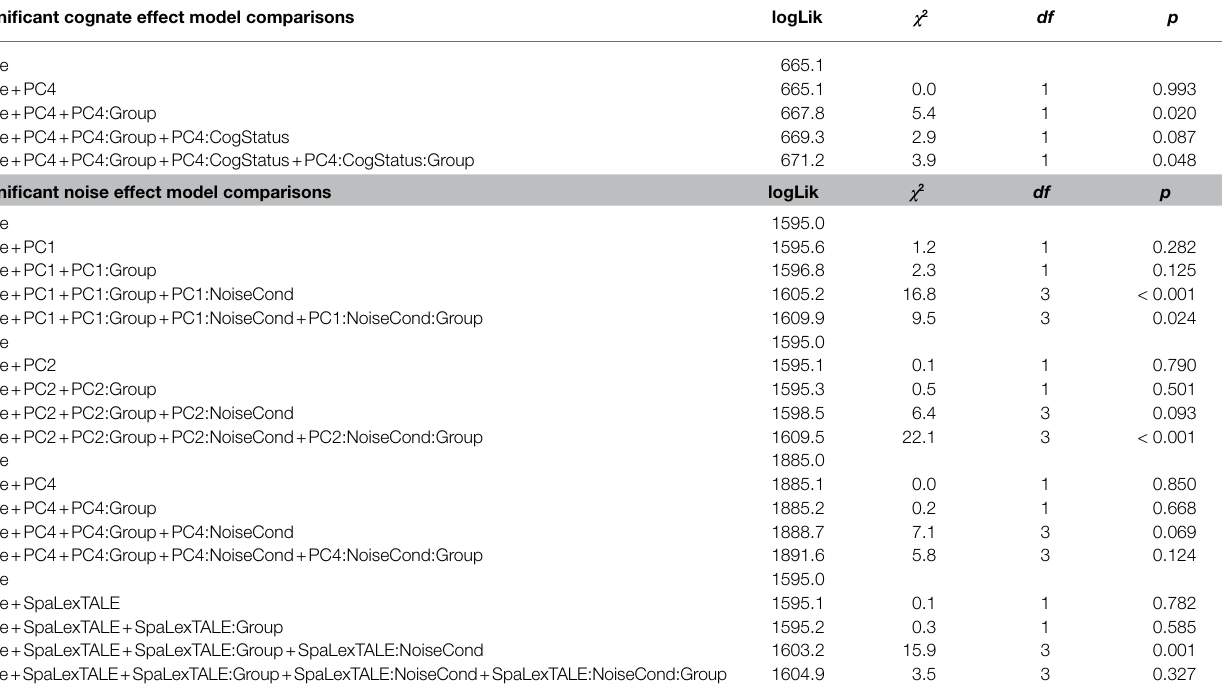
TABLE 7 | Nested comparisons of model log likelihood showing the predictive power of language experience predictors in the first step of the individual differences analysis. Significant cognate effect model comparisons